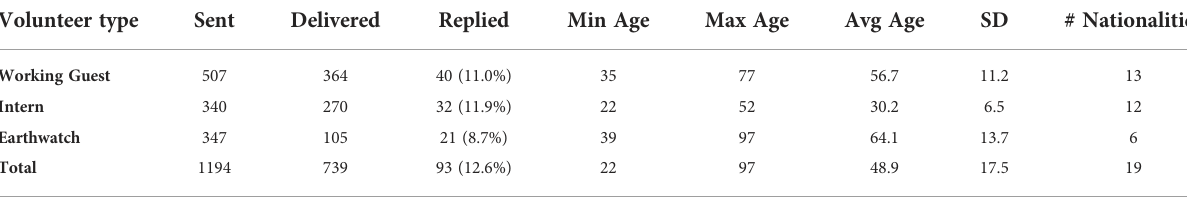
TABLE 2 Demographics of female survey participants from CCF ’ s volunteer programs.